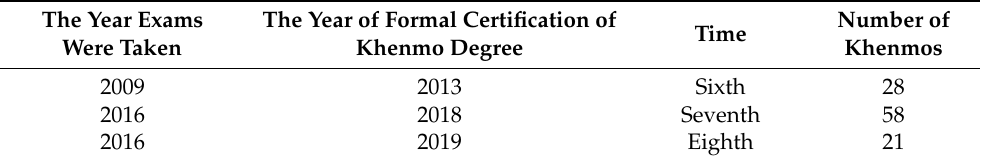
Table 6. Numbers of certified Tibetan Khenmos by year after Khenpo Jigme Phuntsok, until 2019. The Year